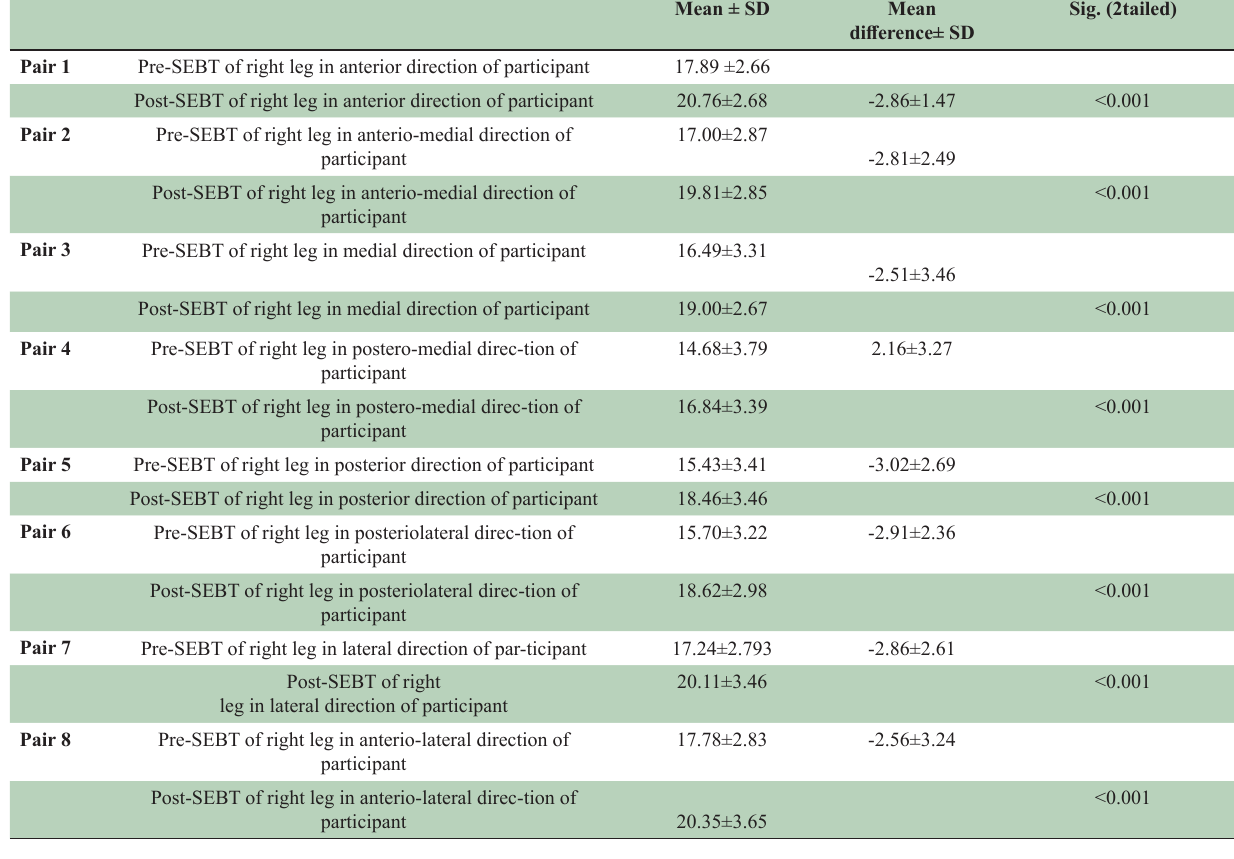
Table-II: Parametric Test (Paired Sample T Test): Pre and Post SEBT findings of rt.